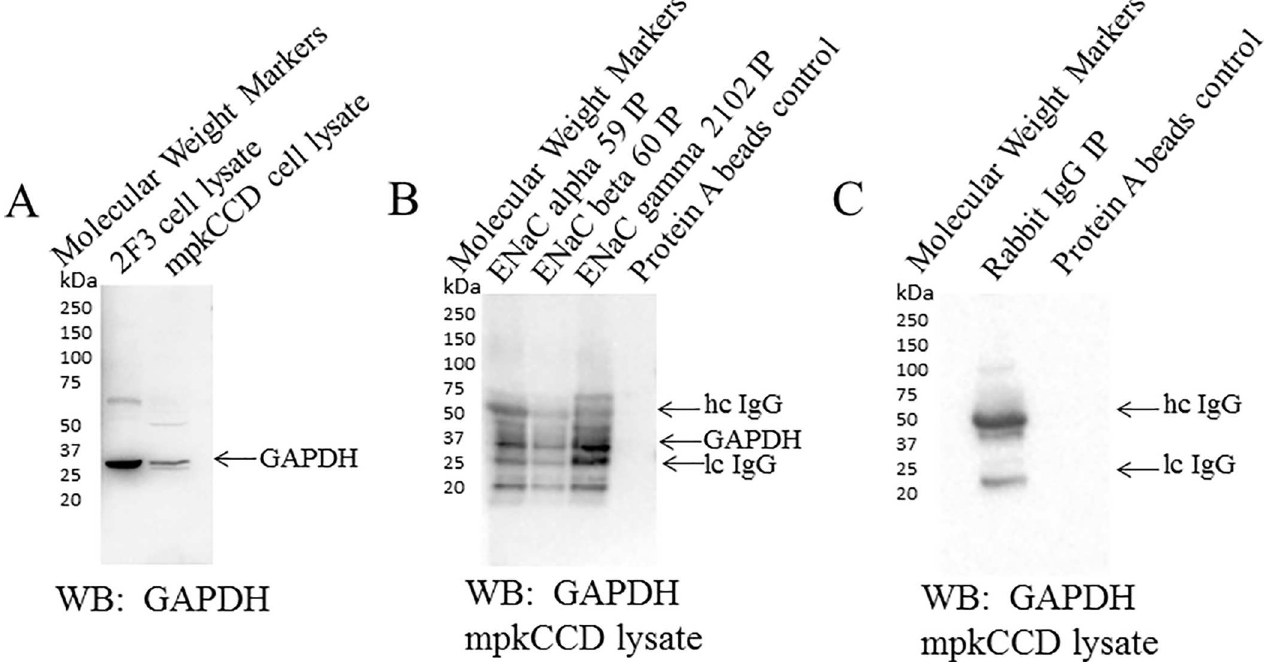
Fig 12. Coimmunoprecipation and Western blot analysis showing an association between GAPDH and ENaC subunits. Polyclonal ENaC alpha, beta, and gamma antibodies were used to immunoprecipatate each subunit from mpkCCD cellular lysates and pull-downprotein binding partners. The eluent from the immunoprecipitated complexes were separated by SDS-PAGE and the blots were probed with GAPDH polyclonal antibody. (A) Western blot analysis showingan immunoreactive band corresponding to GAPDH protein at 35 kDa from both Xenopus2F3 cells and mpkCCD cells. (B) IP-Western showingspecific antibodiesfor ENaC alpha, beta, and gamma subunits pull-downGAPDH from mpkCCD cell lysates. Heavy and light chains of IgG are indicatedby arrows. IP refers to immunoprecipitation. IgG refers to immunoglobulin.